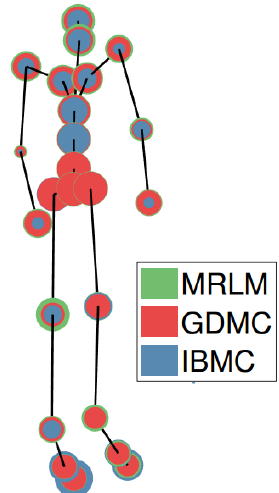
Figure 8. Error per joint. For each joint, we visualize a disk whose radius depends on the average expected error in estimating this joint by each of the three techniques. The skeleton belongs to a 180 cm tall man. The error disks are drawn up to this